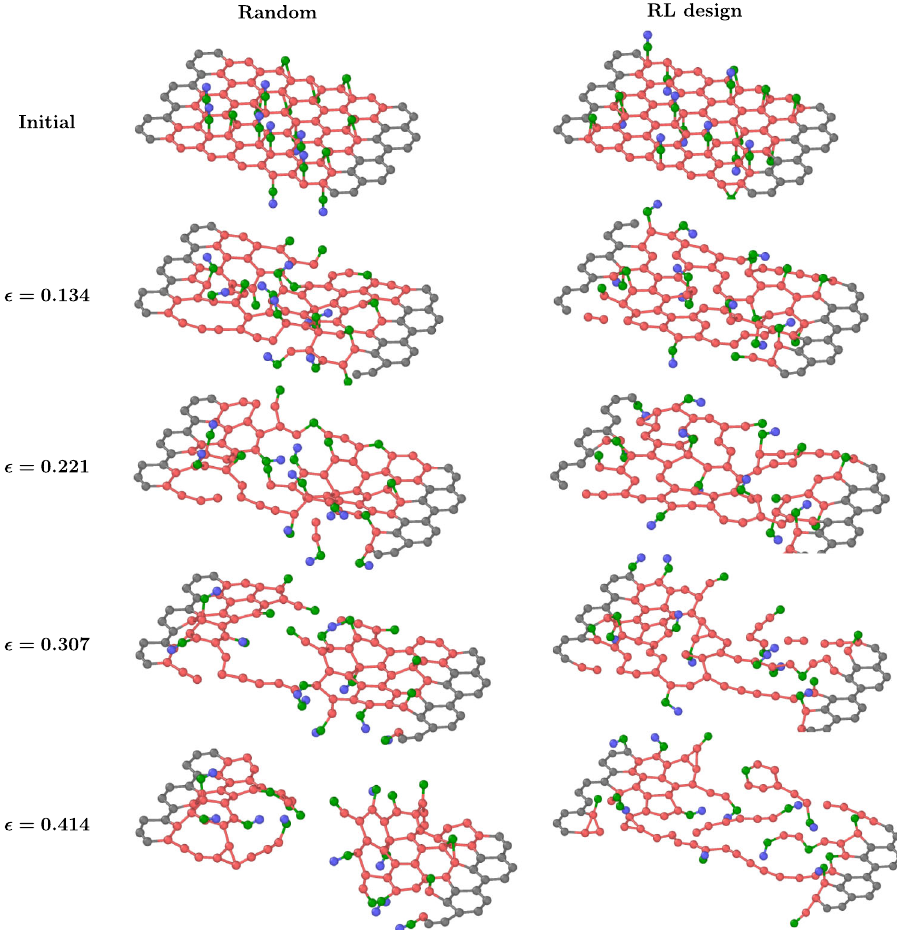
Fig. 4 Rupturing comparison between a random GO and an RL-designed GO. Examples are from the Hard, high-oxidation